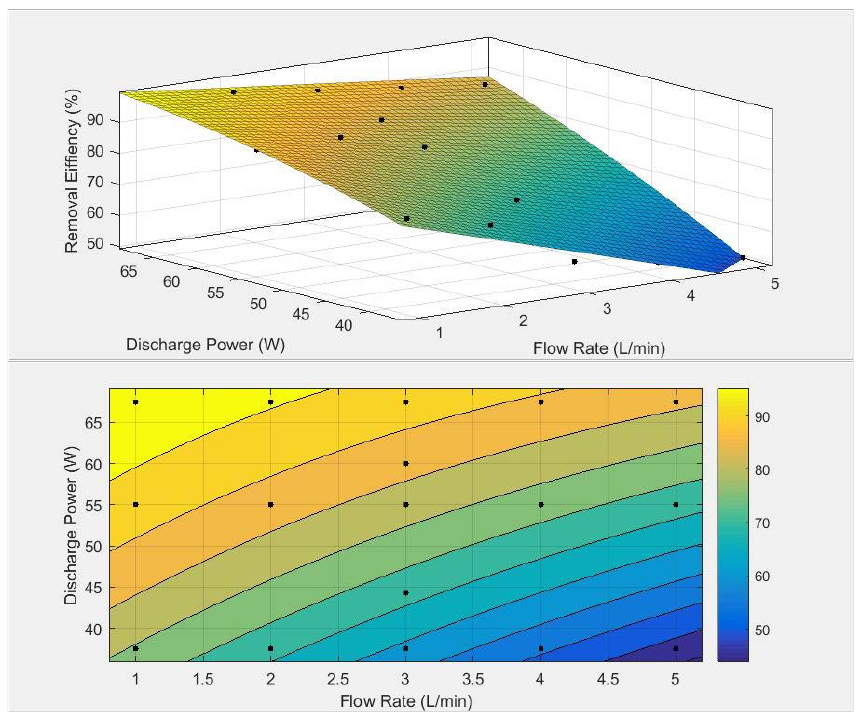
Figure 9. Effect of flow rate and discharge power on efficiency of chlorobenzene in the Cu/γ -Al 2 O 3 reactor.